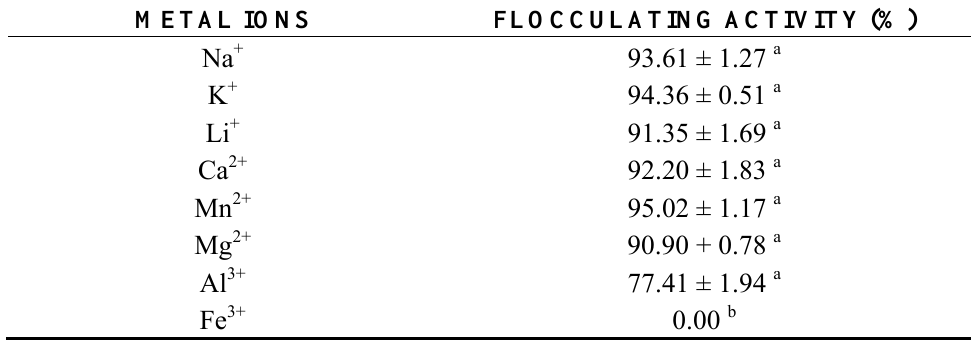
Table 1. Effect of metal ions on bioflocculant production of Cobetia sp.